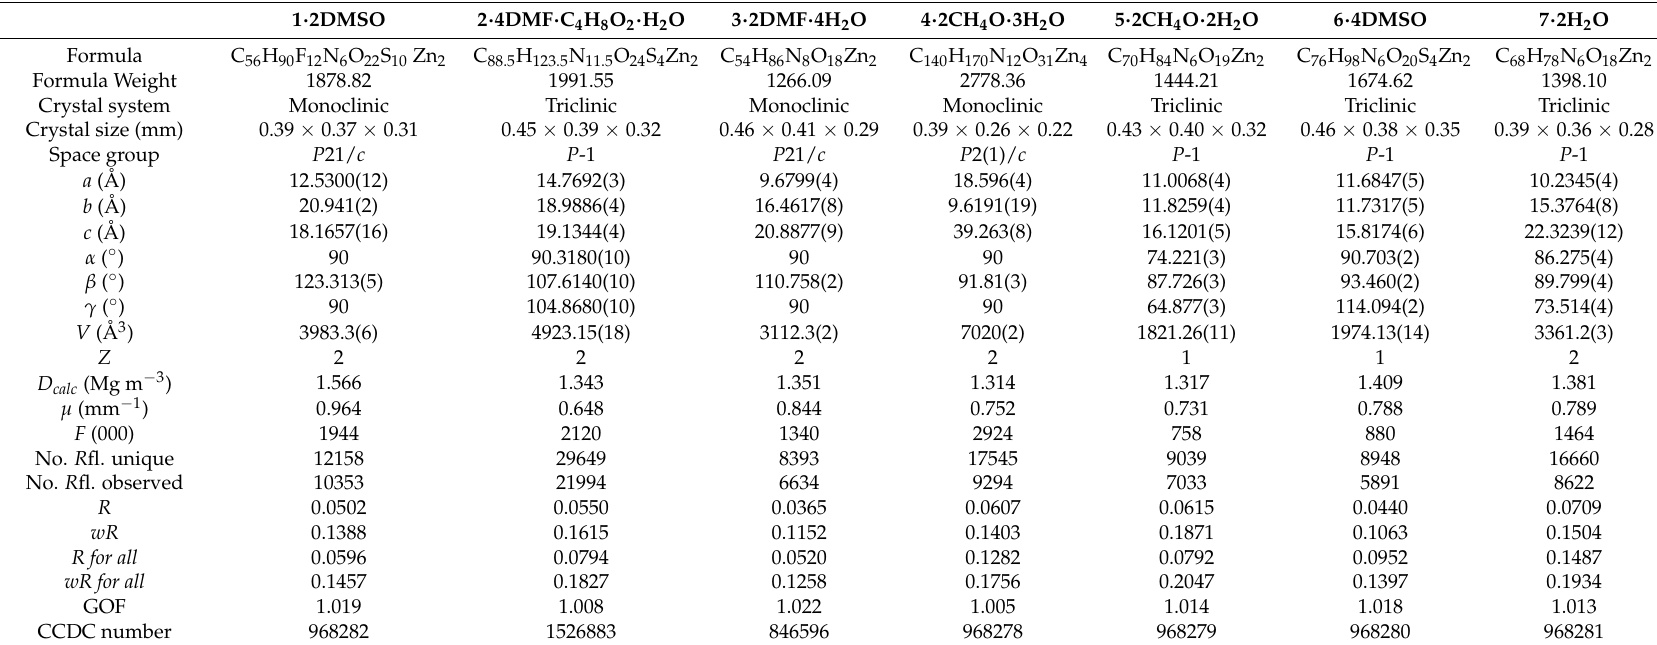
Table 1. Crystallographic data for compounds 1 – 7